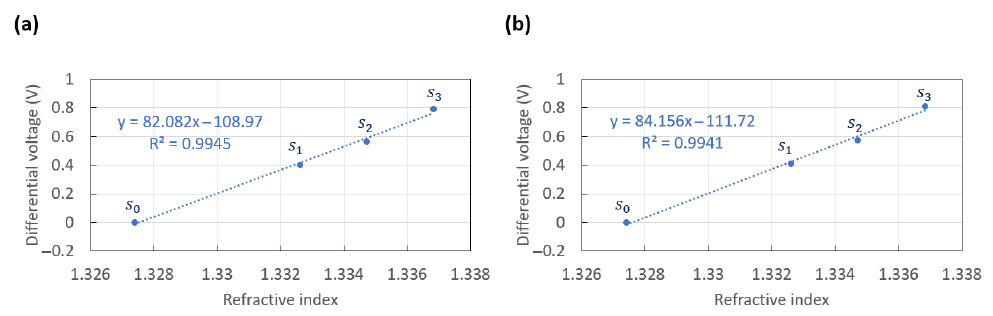
Figure 6. Measured differential voltage vs. refractive index ( λ 0 = 850 nm) of the solutions injected, taken as the mean value measured for the first injection of each solution reported in ( a ) Table 1 at θ l , and ( b ) Table 2 at θ r . The dotted lines correspond to the best fitting linear models.